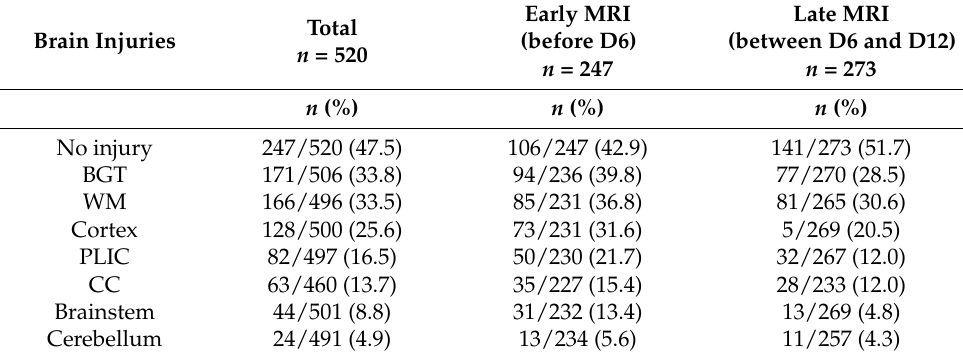
Table 4. Brain injuries in newborns with neonatal encephalopathy by date of